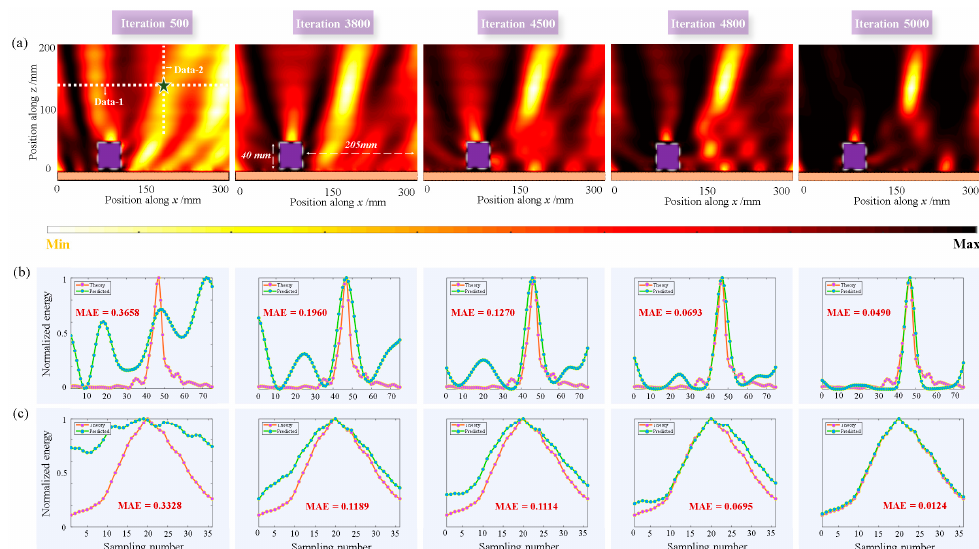
Figure 5. Focusing process in Scenario 1. ( a ) Dynamic focusing process with different iterations under normal incidence. Black five-pointed star represents the position of the target focus and the white-dotted line represents the data obtained by the agent . The length of the sides of the object was 40 mm. ( b ) Network prediction and theoretical results of Data 1 under different iterations and the MAE loss was calculated. ( c ) Network prediction and theoretical results for Data 2 under different iterations.